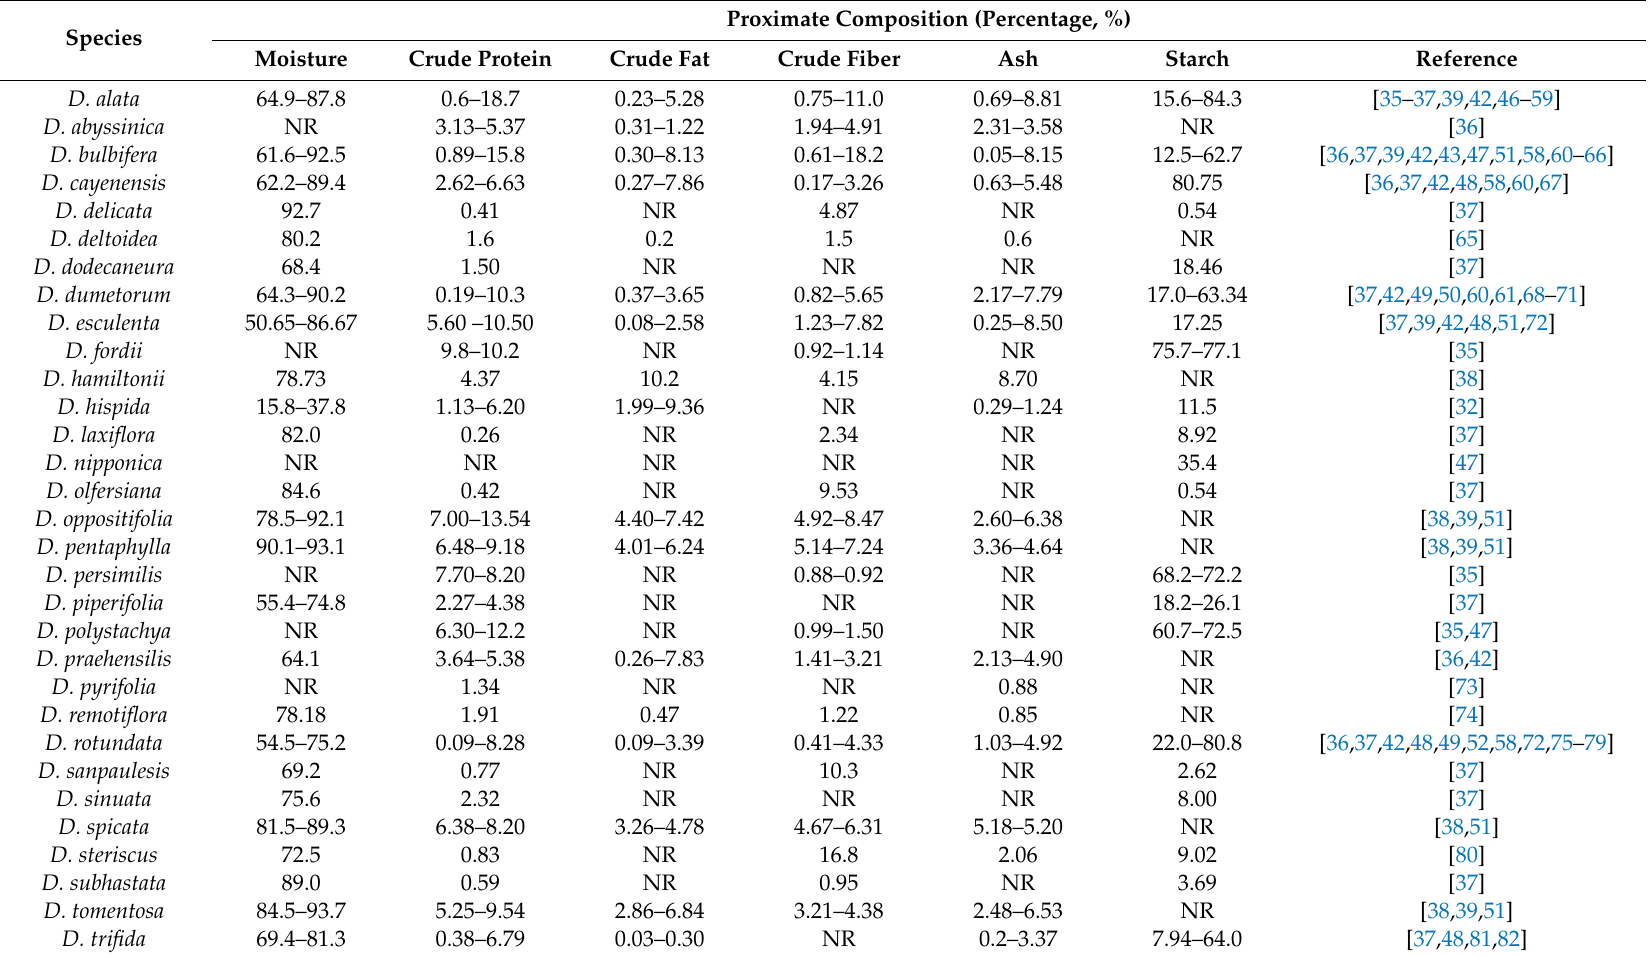
Table 1. Proximate compositions of some species of Dioscorea